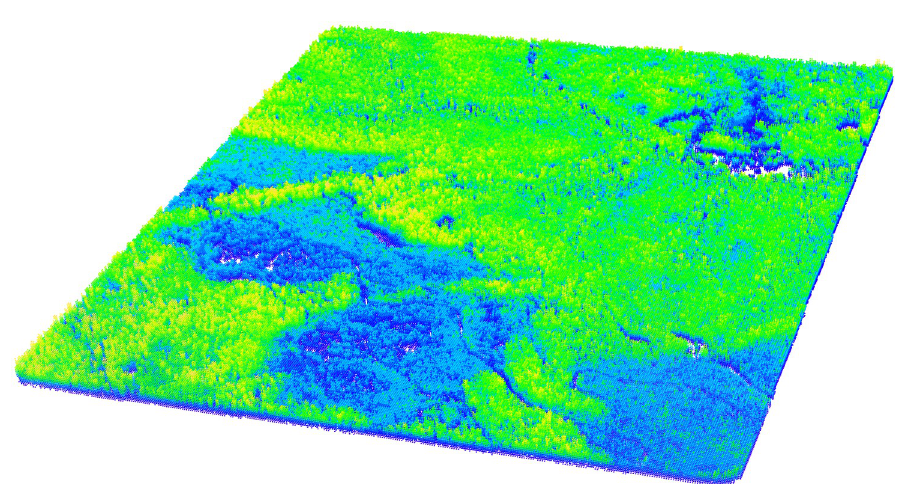
Fig 2. Example PLSS section illustrating an intermediate step in the voxel-based metric calculation process. The section has been divided horizontally and vertically into 5-m resolution voxels. Statistics were then calculated to summarize points contained within each voxel. In this example, each point represents the mean height within the respective 5-m voxel. This data is used to subsequently calculate the voxel-based metrics shown in Table 1 for the entire PLSS